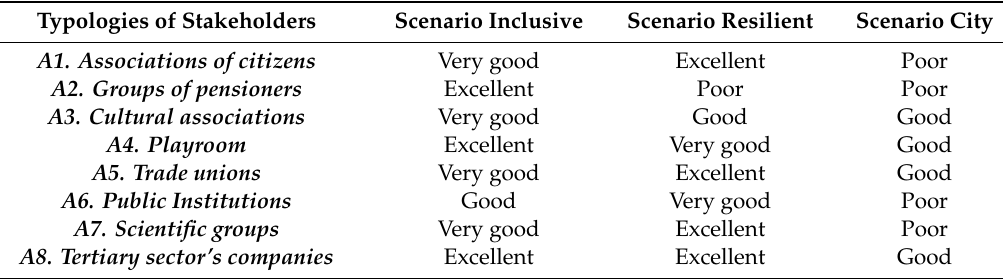
Table 4. The equity matrix—Stakeholder opinions on the three hypotheses